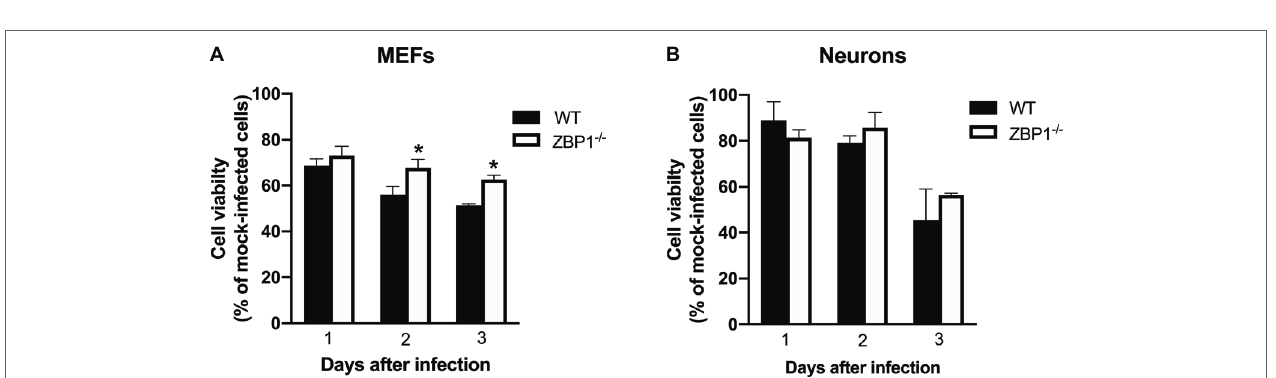
FIGURE 9 | Assay of primary mouse cell viability following WNV infection. (A) MEFs and (B) neuronal cultures from WT and ZBP1 −/− mice were infected with WNV NY99. Cell toxicity on days 1, 2, and 3 after infection was evaluated by cell proliferation assay and the percentage of cell viability was calculated by comparing values to those from mock-infected cells at the corresponding time points. The data are expressed as the mean ± SEM for two independent experiments conducted in triplicate. Error bars represent SEM, * p <